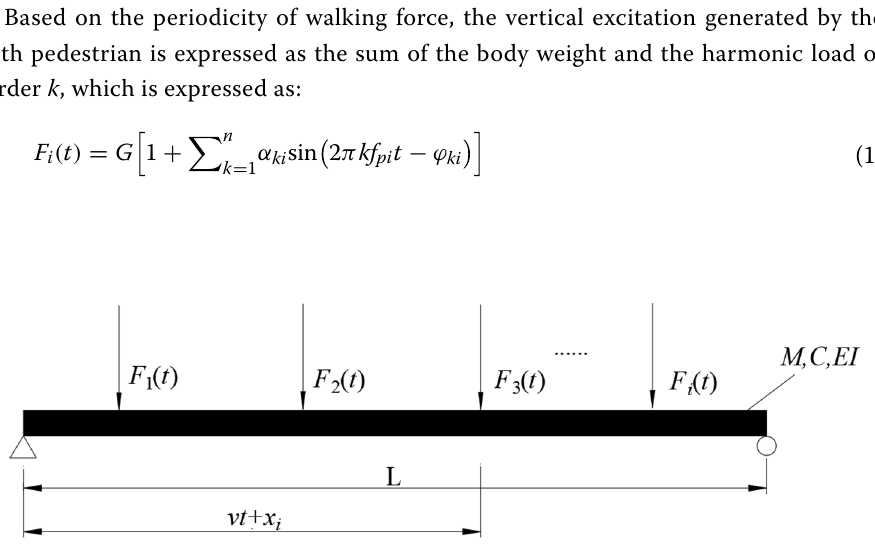
Fig. 1 Simple beam model under multi-pedestrian